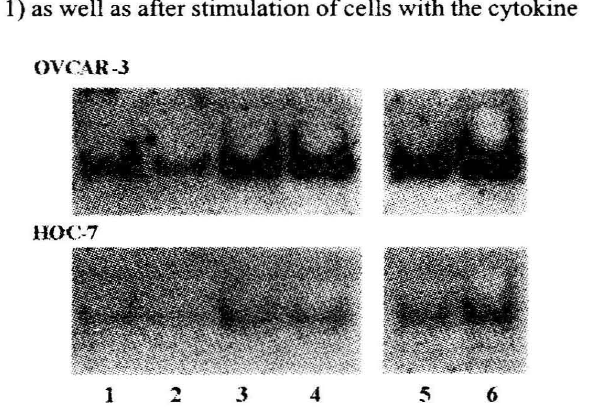
Figure 3. Activation of NF-kB detected by elec trophoretic mobility shift assay in nuclear extracts of ovarian carcinoma cell lines following 1 h incuba tions. Lane 1 = unstimulated controls; lane 2 = cytokine mixture; lane 3 = neopterin (100 11M); lane 4 = neopterin (1000 flM); lane 5 = cytokine mixture + neopterin (100 11M); lane 6 = cytokine mixture + neopterin (1000 11M). Results are representative of 3 different experiments. Cytokine mixture = interferon g (100 U/ml) + interleukin-lil (10 U/ml) + tumor necrosis factor-a (500